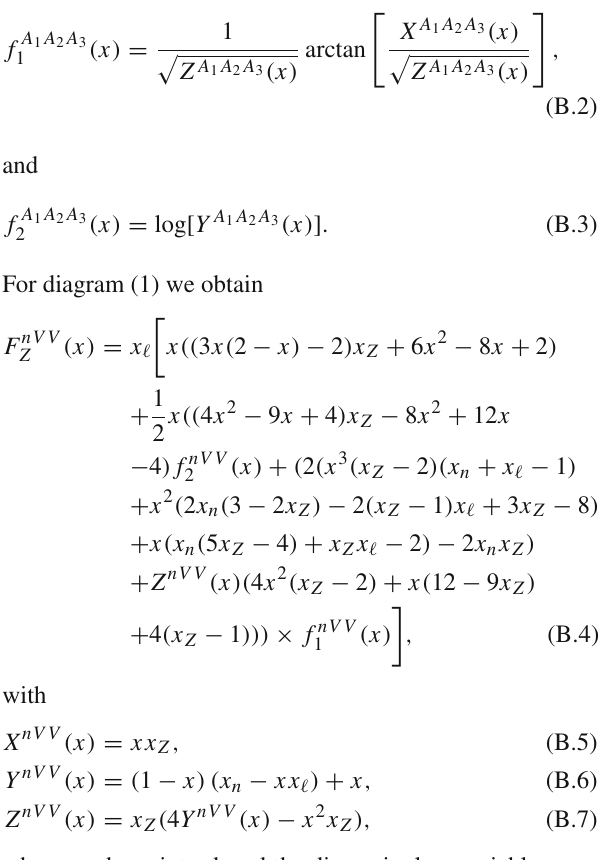
and f A 1 A 2 A 3 Z